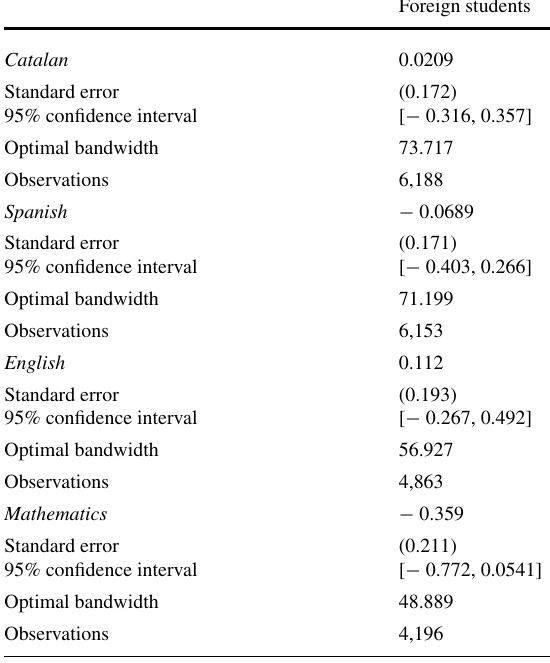
Table 10 Diff-in-disc regression results, foreign students